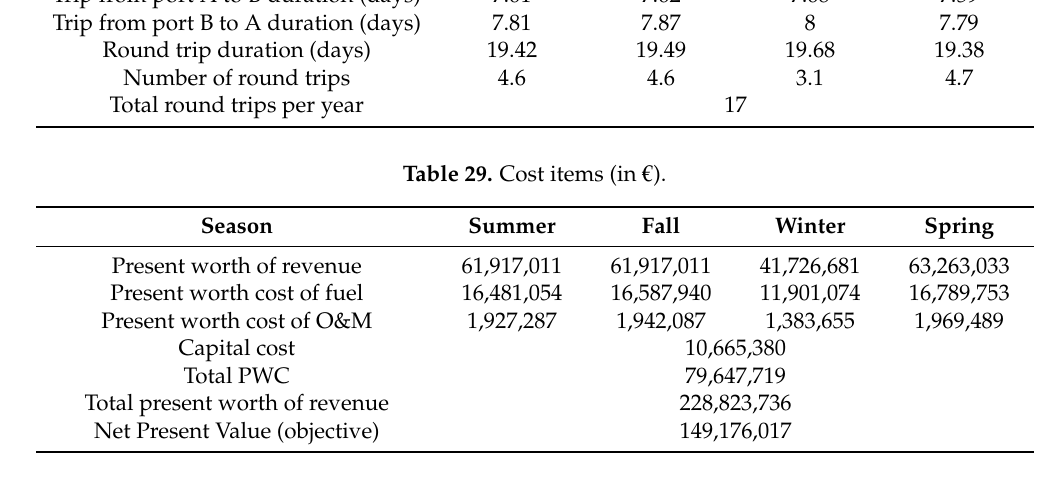
Table 30. Optimal ship speed versus time (in